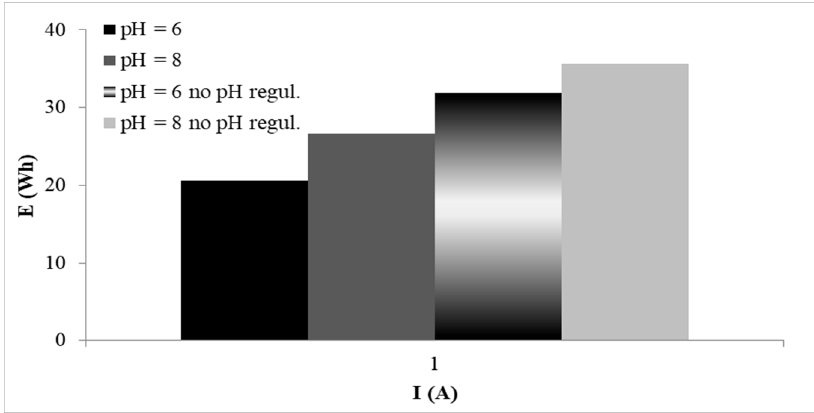
Figure 5. EC energy consumption with and without pH regulation. Volume = 350 mL, model solution, c (NaCl) = 3000 mg/L.